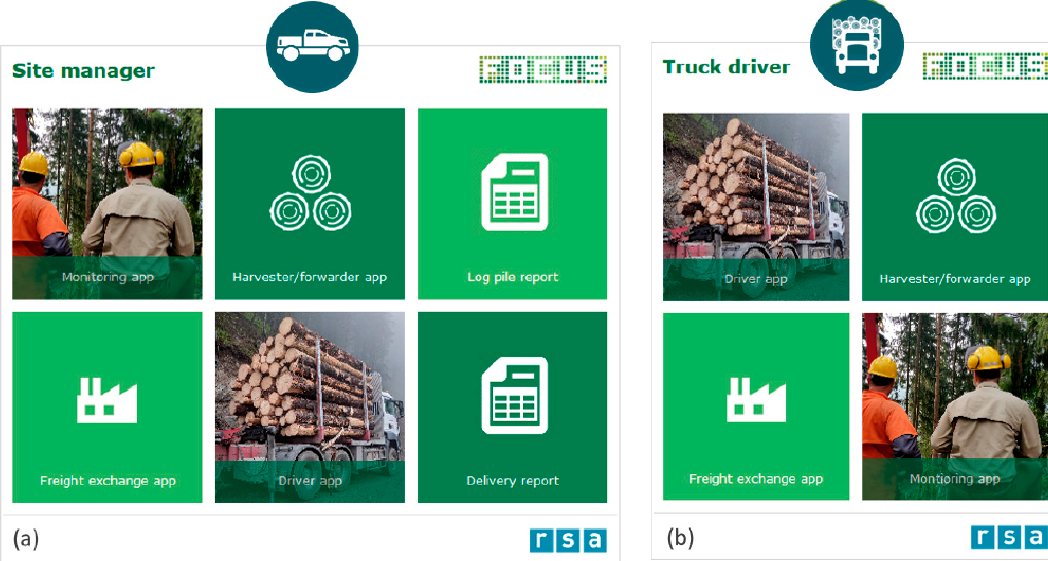
Figure 2. Two exemplary start pages showing ( a ) the view for the site managers, and ( b ) the view for 229 the truck drivers using the task-oriented design metaphor. 230